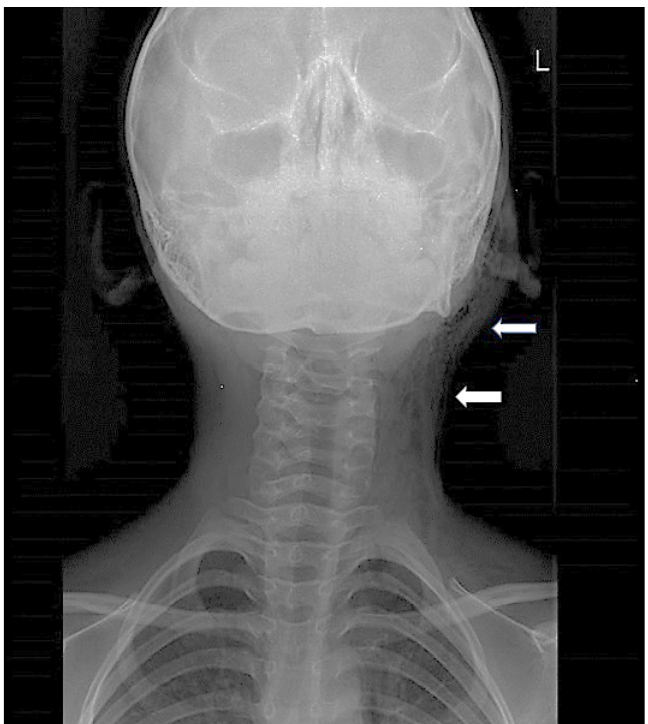
Image 2 . Anterior-posterior radiograph of the neck demonstrating extensive left-sided cervicofacial subcutaneous emphysema (arrows).